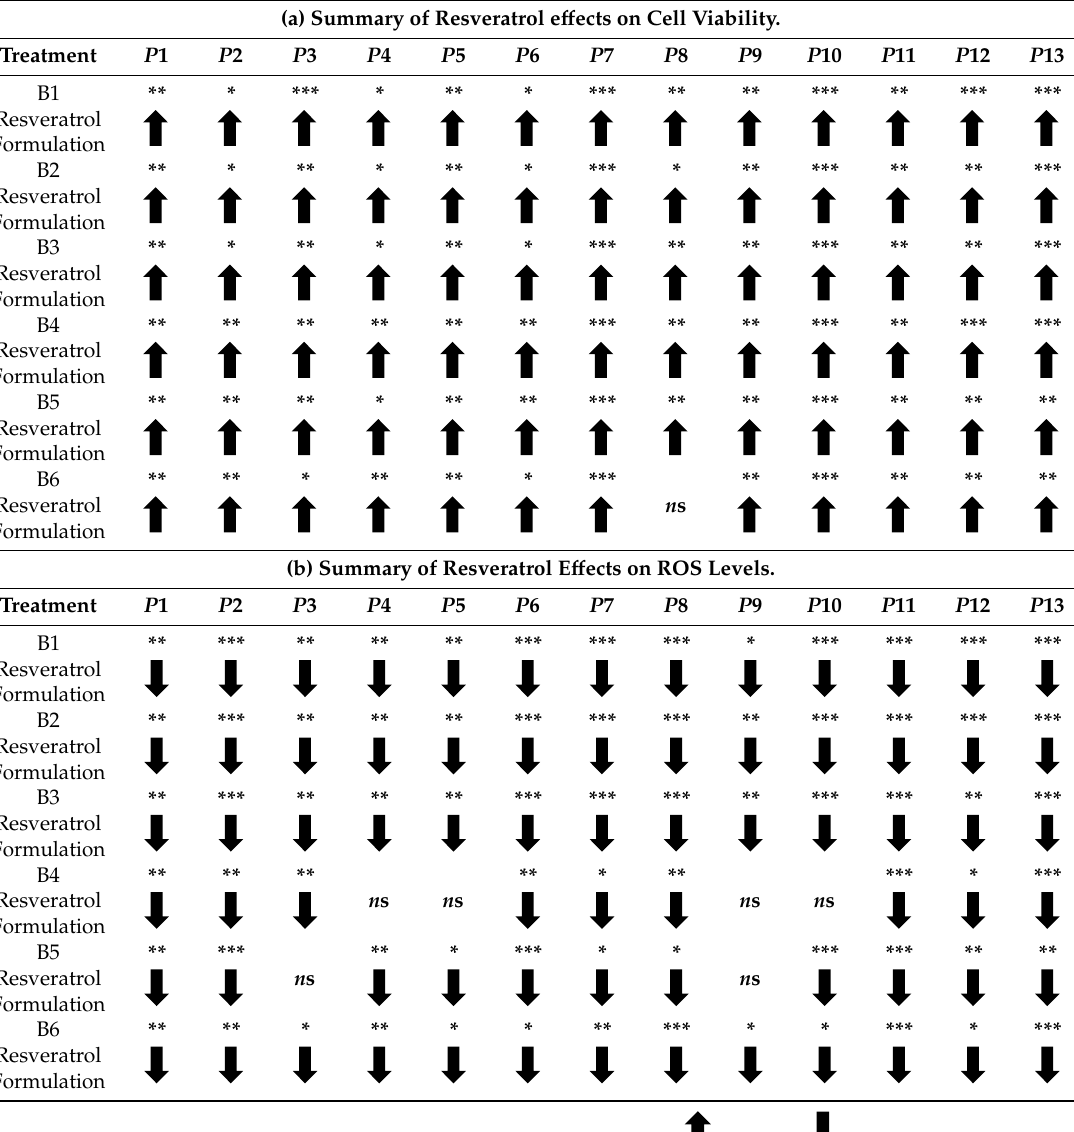
Table 9b); AMD Patient #8 cybrid—28.33% decrease; p = 0.0006; (Figure 9B, Table 10b); AMD Patient #9 cybrid—18.38% decrease; p = 0.0159; (Figure 10B, Table 11b); AMD Patient #10 cybrid—13.47% decrease; p = 0.0262; (Figure 11B, Table 12b); AMD Patient #11 cybrid—33.61% decrease; p = 0.0002; (Figure 12B, Table 13b); AMD Patient #12 cybrid—11.33% decrease; p = 0.0317; (Figure 13B, Table 14b); Table 16a,b summarize the e ff ects of treatment with various resveratrol formulations in AMD patients. Table 16. Summary of the e ff ects of resveratrol formulations on cell viability ( a ) and ROS levels ( b ) in all AMD patients # 1–13. (a) Summary of Resveratrol e ff ects on Cell